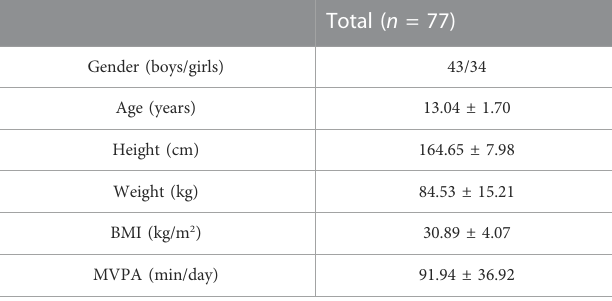
TABLE 1 Basic characteristics of